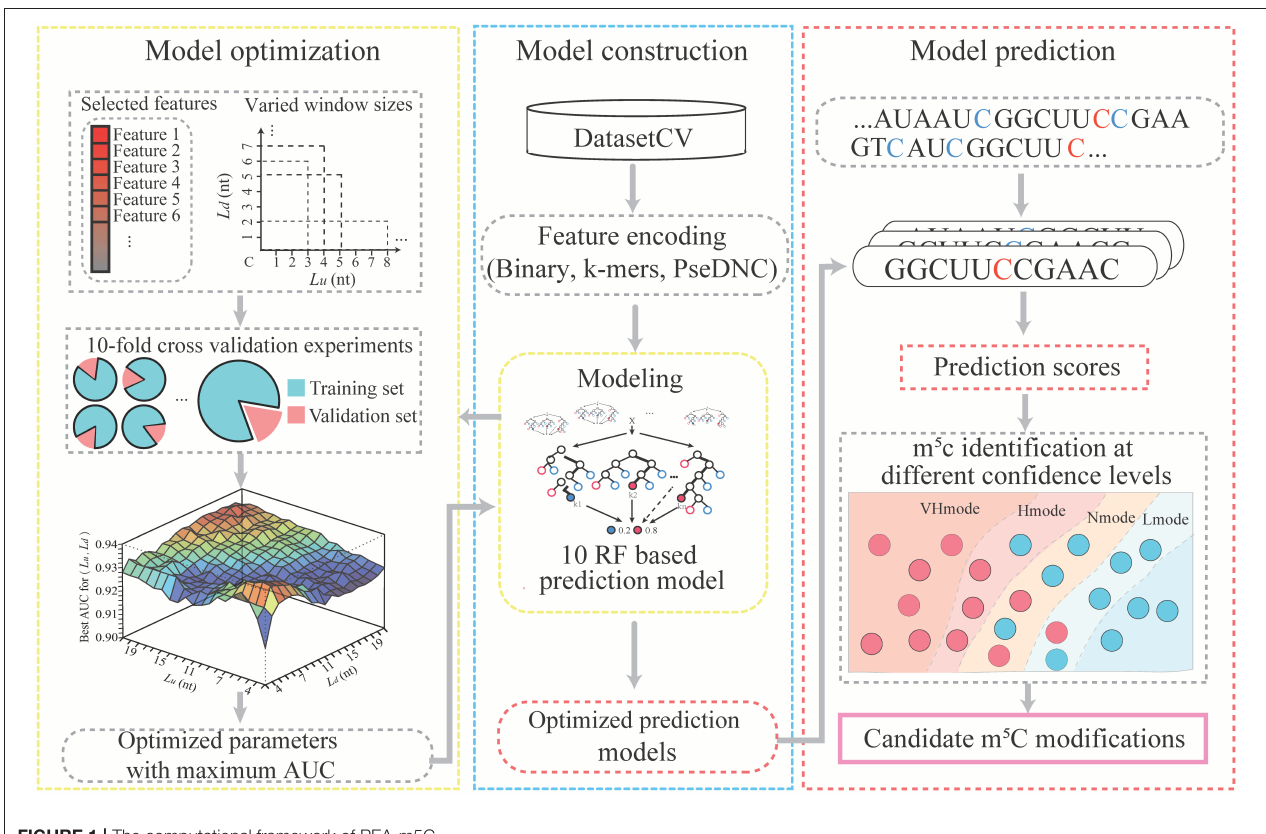
FIGURE 1 | The computational framework of PEA-m5C.